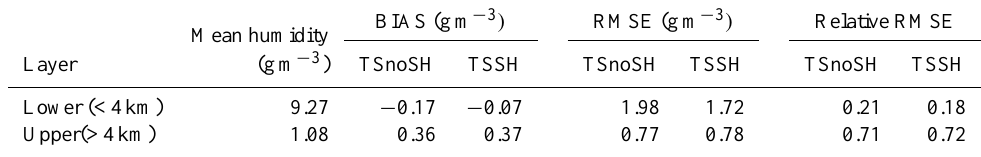
Table 4. Mean humidity derived from radiosonde in lower and upper layer of atmosphere. The BIAS, RMSE and relative RMSE of tomo- graphic solutions compared with radiosonde are also computed in two layers.